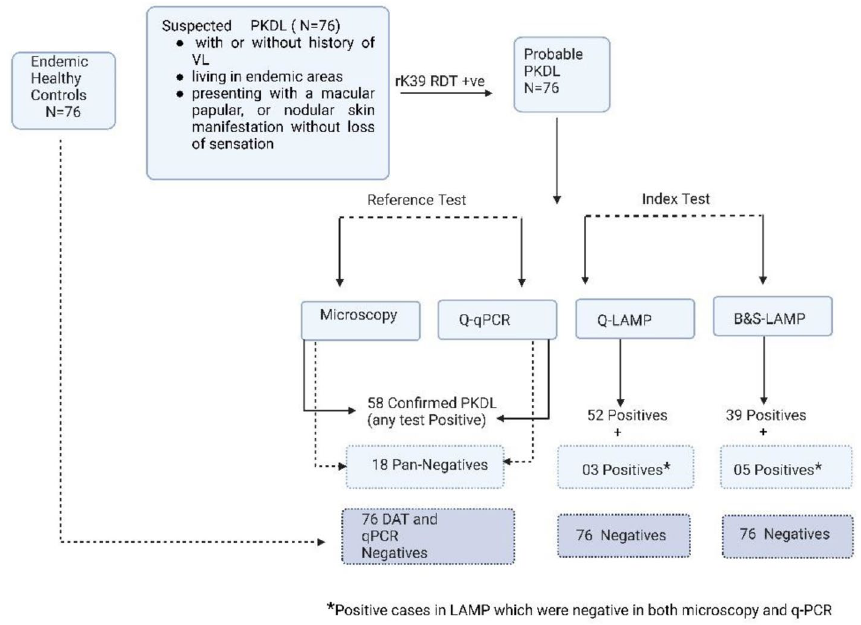
Figure 2. Study flow-diagram representing the inclusion of study participants and eventual diagnosis through index and reference tests.